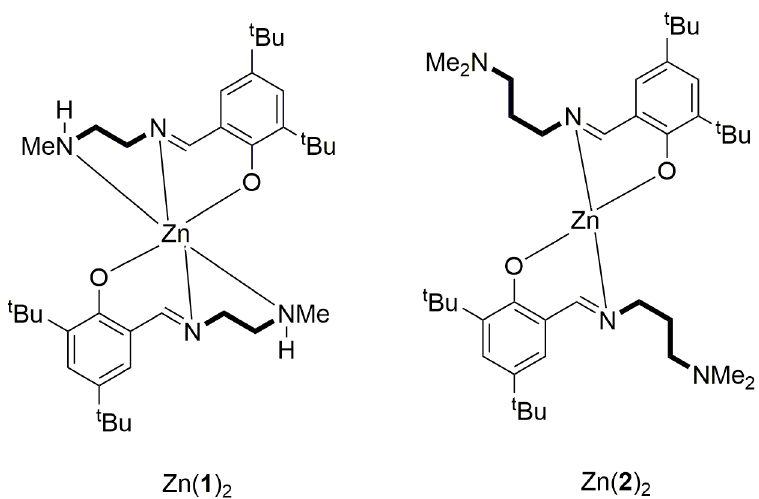
Figure 1. Chemical structure of the two catalysts zinc ethylenediamine Schiff-based complex (Zn( 1 ) 2 ) and propylenediamine Schiff-based complex (Zn( 2 ) 2 ).